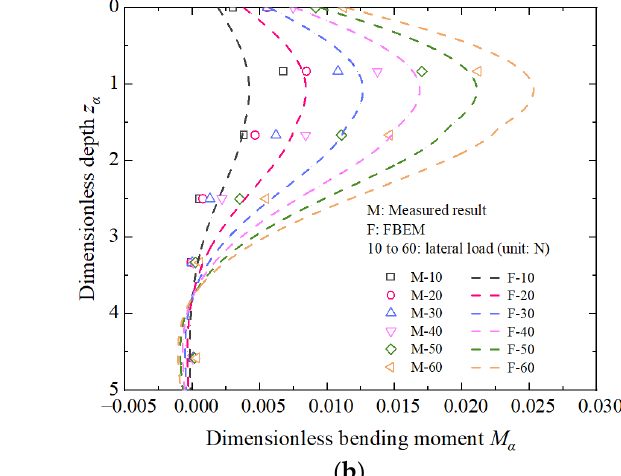
Figure 7. Comparisons of lateral load versus pile head deflection curves in lateral static loading tests.